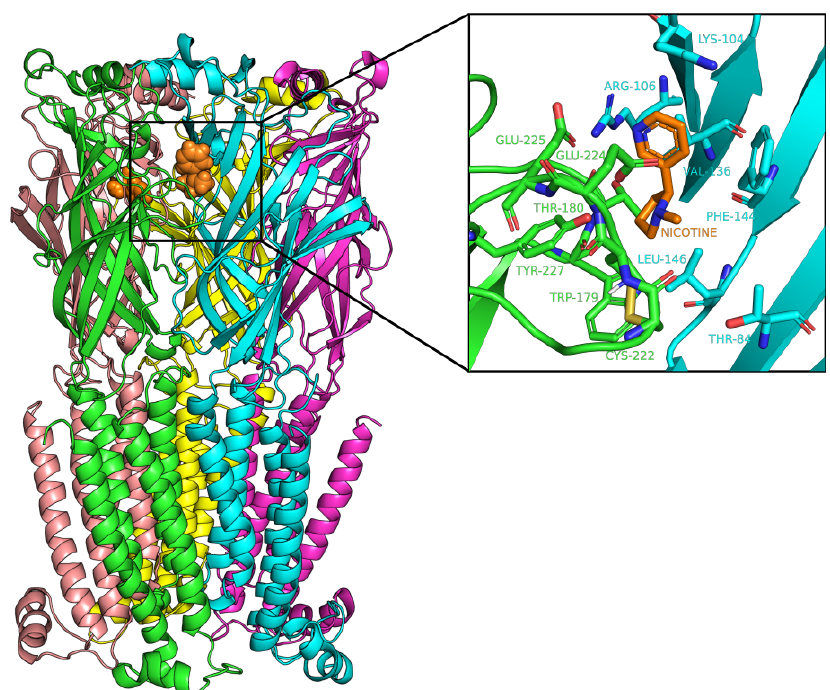
Figure 1. Homology model α 6 β 2 nicotinic receptor. ( Left ) View through the plasma membrane. The alpha helices span the plasma membrane. The two α 6 subunits are colored green and yellow, and the three β 2 subunits are colored brown, blue, and magenta. Orange van der Waals spheres represent the nicotine. ( Right ) Binding pocket of the receptor showing nicotine as orange sticks and the various binding site residues from α 6 chain (green) and β 2 chain (blue).